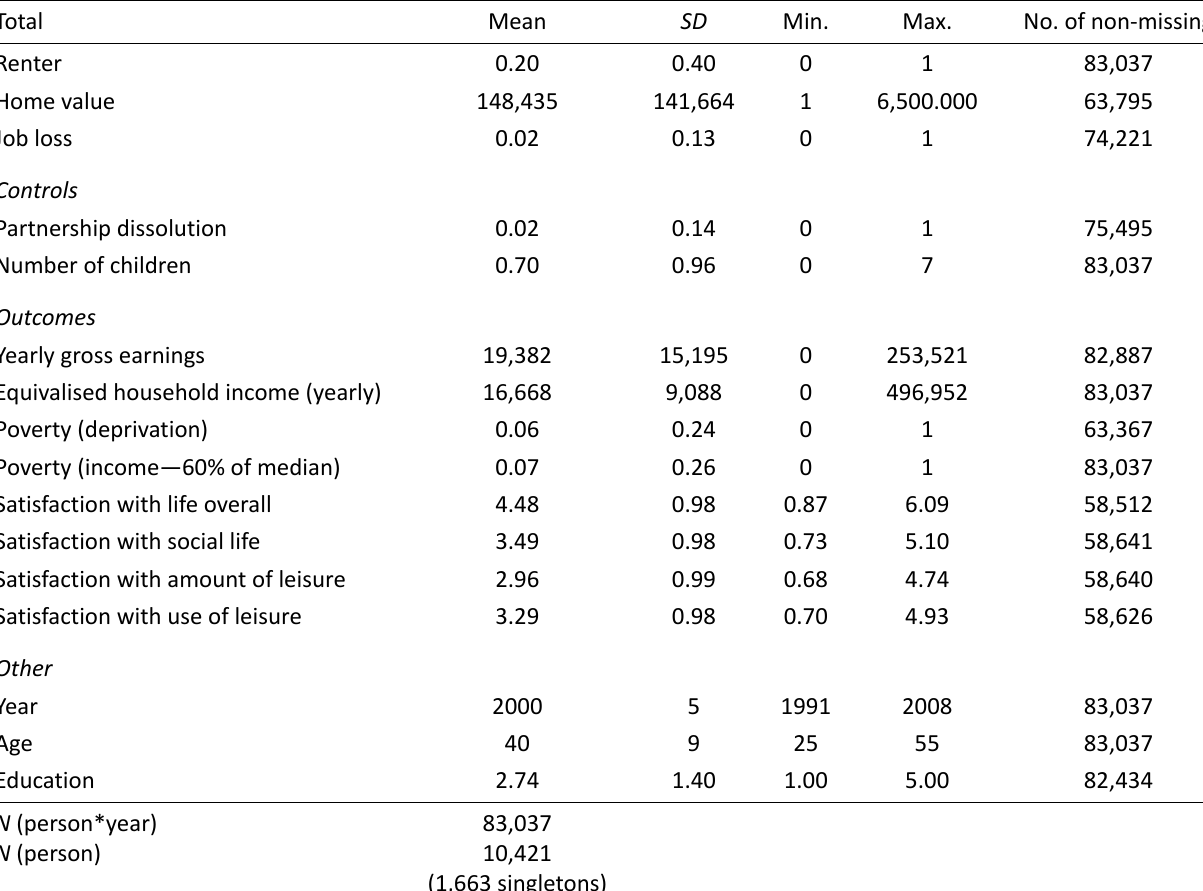
Table 1. Descriptive statistics: Total